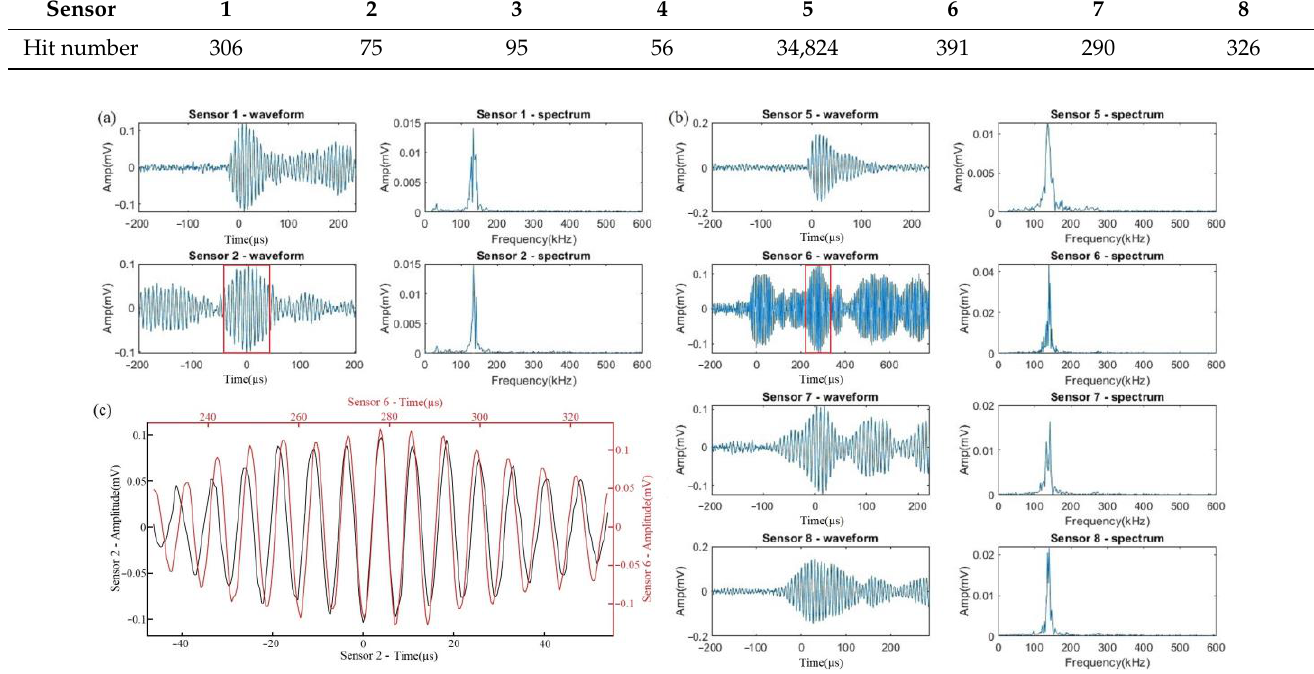
Figure 6. The waveforms and spectrums from the same event of H2 evolution acquired by ( a ) Nano30 sensors; ( b ) VS150-RIC sensors. ( c ) Partial waveform comparison at the amplitude peaks of signals from Sensors 2 and 6.